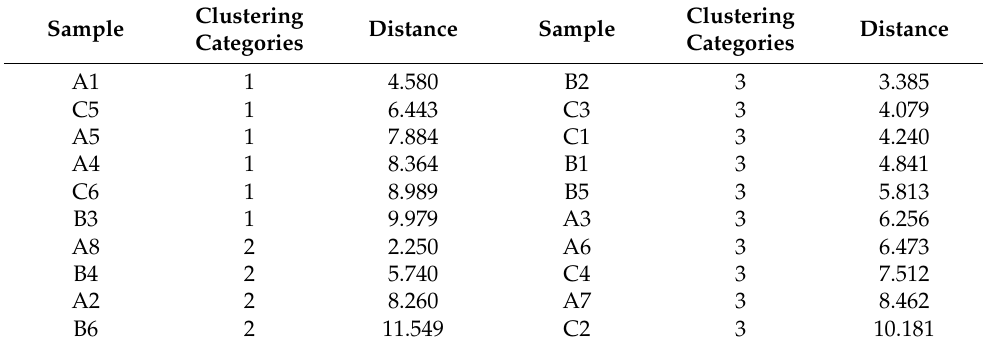
Table 2. Characteristics of sewage sludge from different wastewater treatment plants.